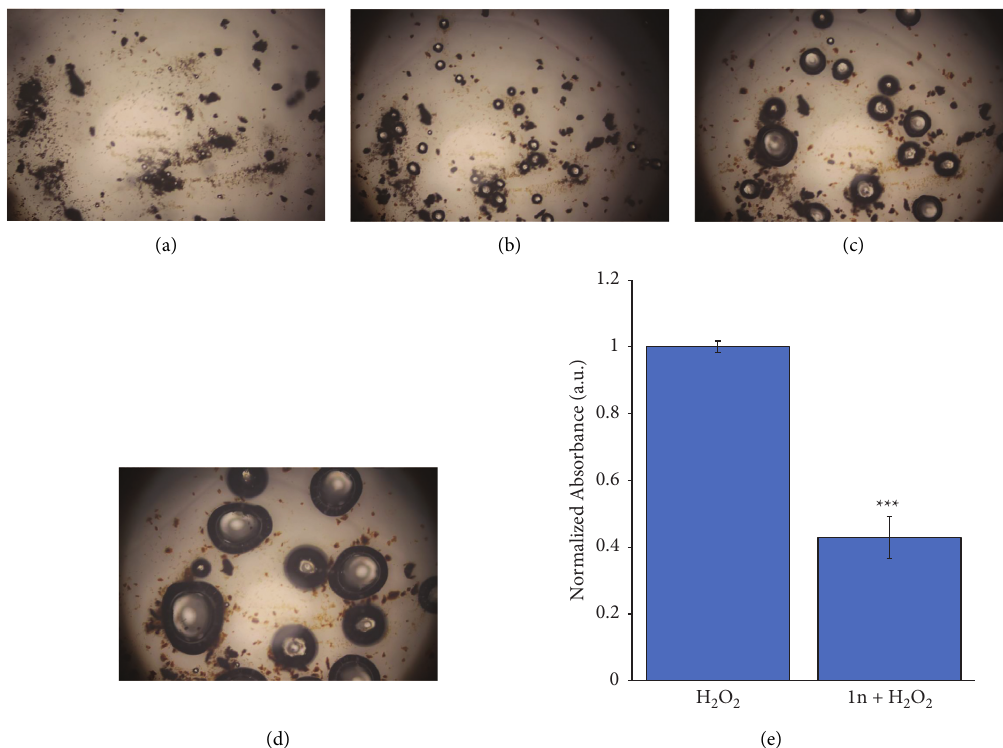
Figure 5: Oxygen bubbles generation when 1n is exposed to H � 0, (b) t � 10 s, (c) t � 20s, and (d) t � 30s. Absorbance of 2 O 2 30% for (a) t chromic acetate in the presence of H 2 O 2 (left bar) and after the incubation with 1n (right bar). The data correspond to mean ± S.D. values from four experiments (e). Statistical analysis was performed using one-way ANOVA Tukey’s test (each group vs. control). ∗∗∗ P < 0 .